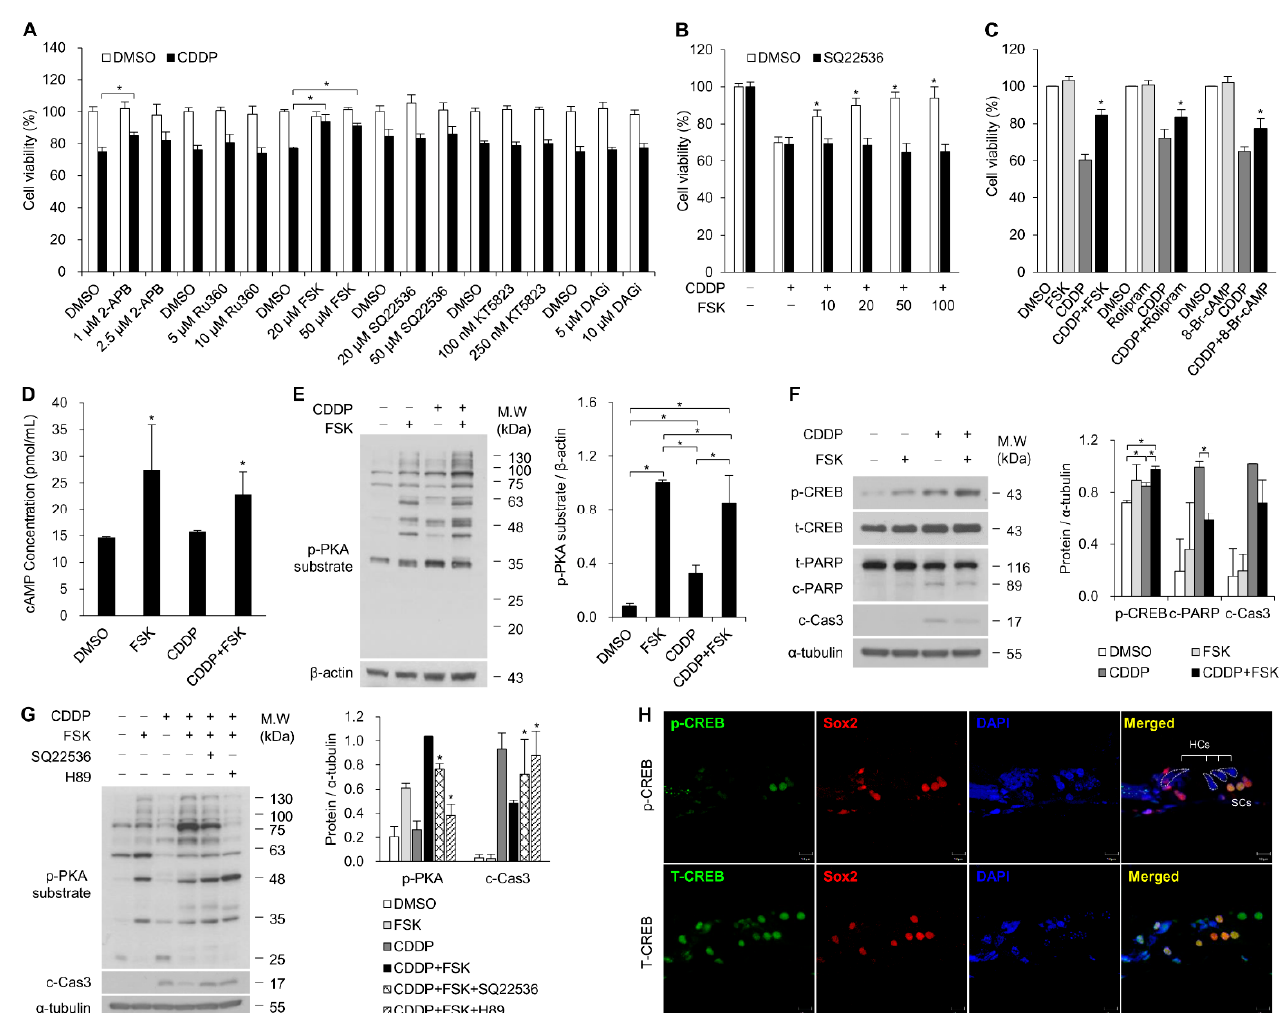
Figure 1. Increased cAMP due to FSK protects against CDDP-induced auditory cell death through upregulation of the cAMP/PKA/CREB pathway. All bar graphs show mean ± standard deviation (* p < 0.05). ( A ) Screening for compounds that can pass through gap junctions and inhibit CDDP-induced ototoxic cell death. HEI-OC1 cells were incubated with 2-ABP, Ru360, KT5823, FSK, SQ22536, and DAGi for 2 h and then co-treated with 15 µ M CDDP for 24 h. Cell viability was quantified by water-soluble tetrazolium salt (WST-1) assay. ( B ) HEI-OC1 cells were treated with various concentrations of FSK along with CDDP or CDDP + SQ22536. ( C ) Effects of the cAMP-elevating compounds FSK (adenylyl cyclase activator), rolipram (PDE4 inhibitor), and 8-Br-cAMP (cAMP analogue) against CDDP-induced effects on cell viability. HEI-OC1 cells were incubated with 20 µ M FSK, 20 µ M rolipram, and 0.1 mM 8-Br-cAMP for 2 h and then co-treated with 15 µ M CDDP for 24 h. * p < 0.05 relative to CDDP treatments. ( D ) Intracellular cAMP levels were measured using ELISA in HEI-OC1 cells treated with 20 µ M FSK and 15 µ M CDDP. ( E , F ) Organ of Corti primary cells were treated with 25 µ M CDDP after pretreatment with 25 µ M FSK for 24 h. The p-PKA level was analyzed by Western blot and normalized to β -actin. The phosphorylated and total forms of CREB, cleaved PARP, and caspase-3 were detected via Western blot. p-CREB was normalized to total CREB, while cleaved PARP and caspase-3 were normalized to α -tubulin levels. ( G ) Western blot analyses of p-PKA and cleaved caspase-3 using organ of Corti primary cell lysates derived from cultures treated with 25 µ M FSK for 24 h with the adenylate cyclase inhibitor SQ22536 (50 µ M) or PKA inhibitor H89 (5 µ M). Significant differences were found between CDDP + FSK and CDDP + FSK + SQ22536 or H89 treatments. ( H ) Immunohistochemistry of phosphorylated and total CREB in the organ of Corti at 7 weeks. The white dotted lines indicate the contours of the